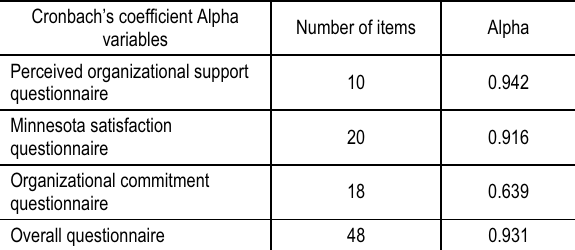
Table 2. Cronbach’s Alpha reliable